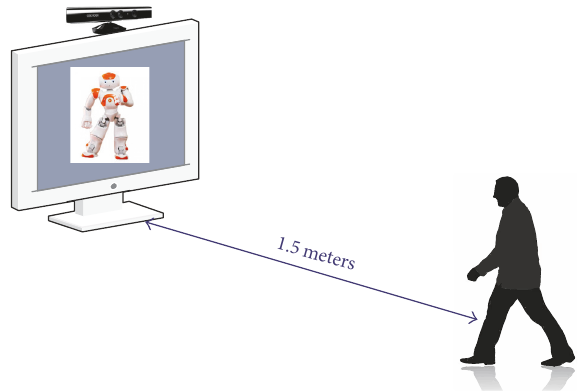
Figure 5: Settings for performance